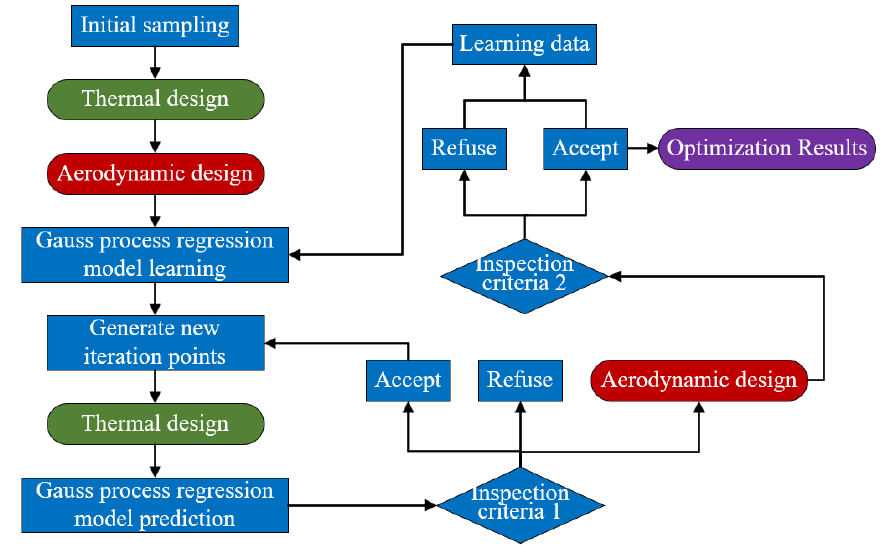
Figure 3. The design-optimization method based on the Gauss process regression.